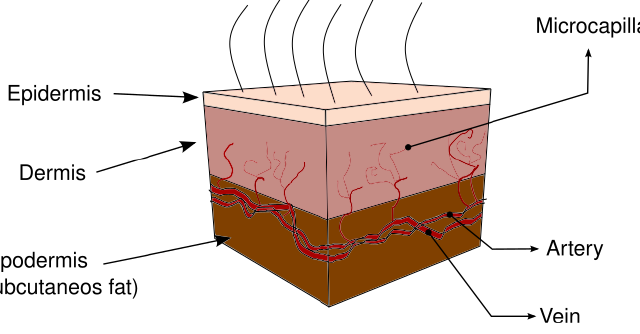
Figure 1. Human skin